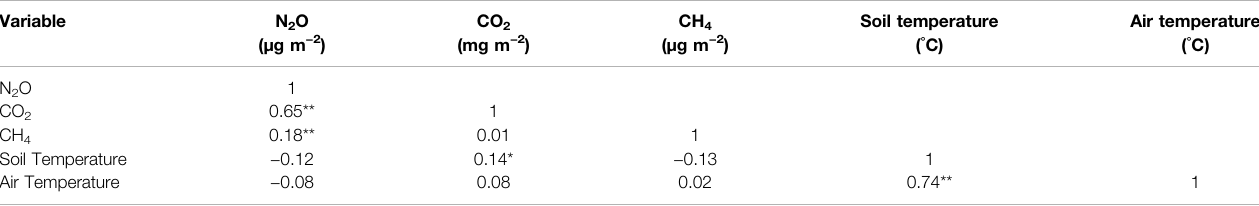
TABLE 3 | Correlation values for the greenhouse gas fl uxes and emissions and soil and ambient temperature during the spring freeze-thaw events ( n = 224). Variable N 2 O